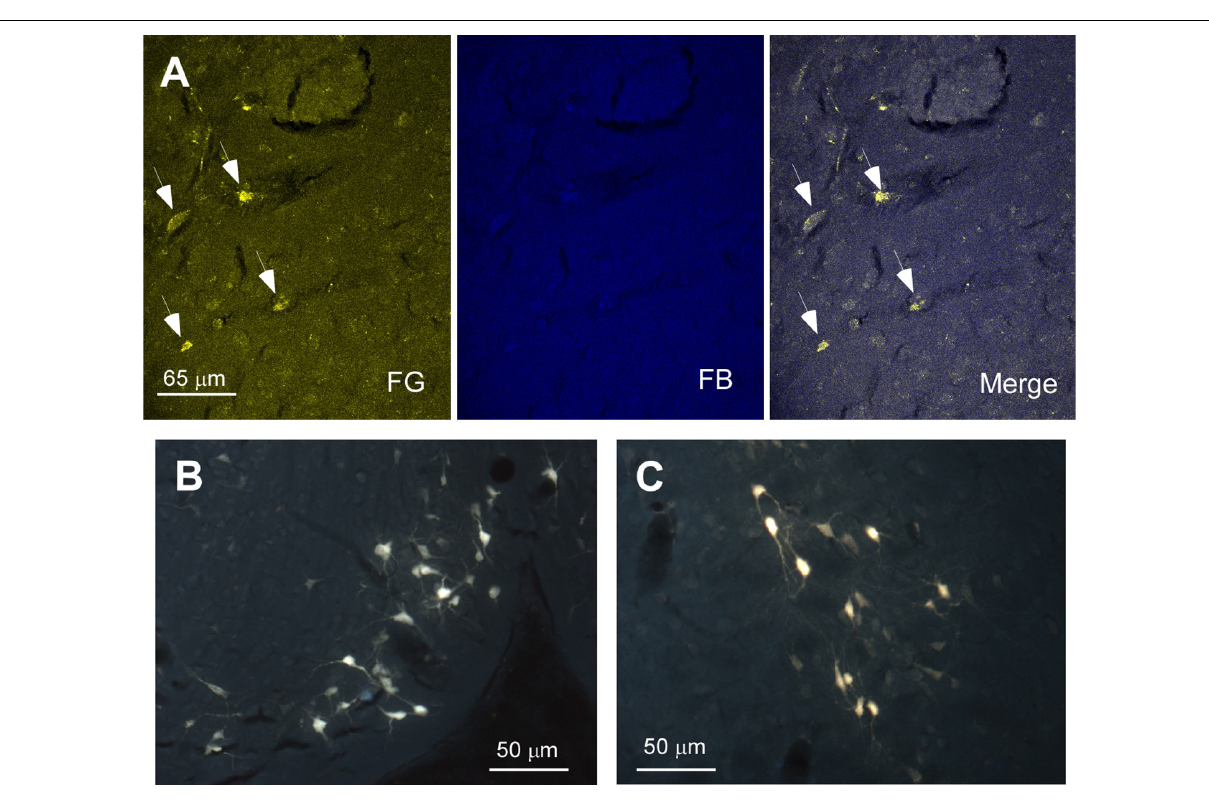
FIGURE 2 | Microphotographs of HDB labeled neurons after injections/deposits in S1/A1 cortices. (A) Confocal images of HDB neurons in a representative animal. Note the few neurons stained with FB (deposit in A1). Thus, the merge does not show double-labeled neurons. (B,C) Microphotographs under fluorescence microscope showing HDB labeled neurons. Arrows indicate FG labeled